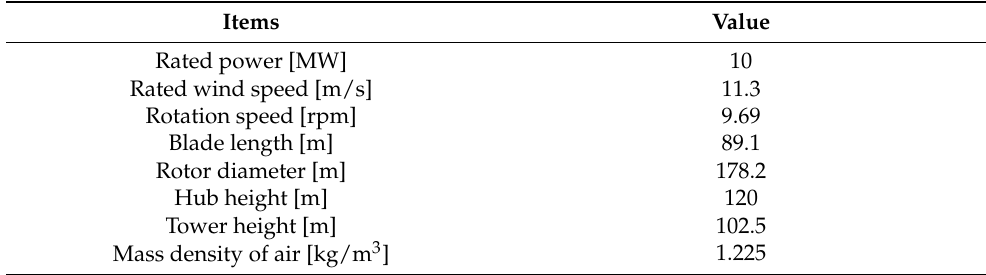
Table 4. Specifications of the 10 MW class FOWT.